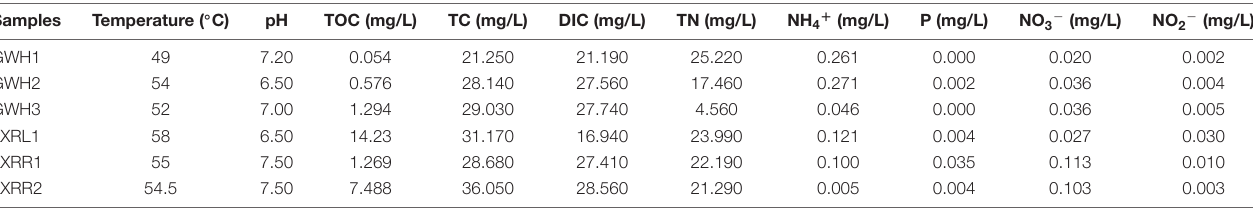
TABLE 1 | Physicochemical characteristics of the samples collected from the hot springs of Conghua, China. Samples